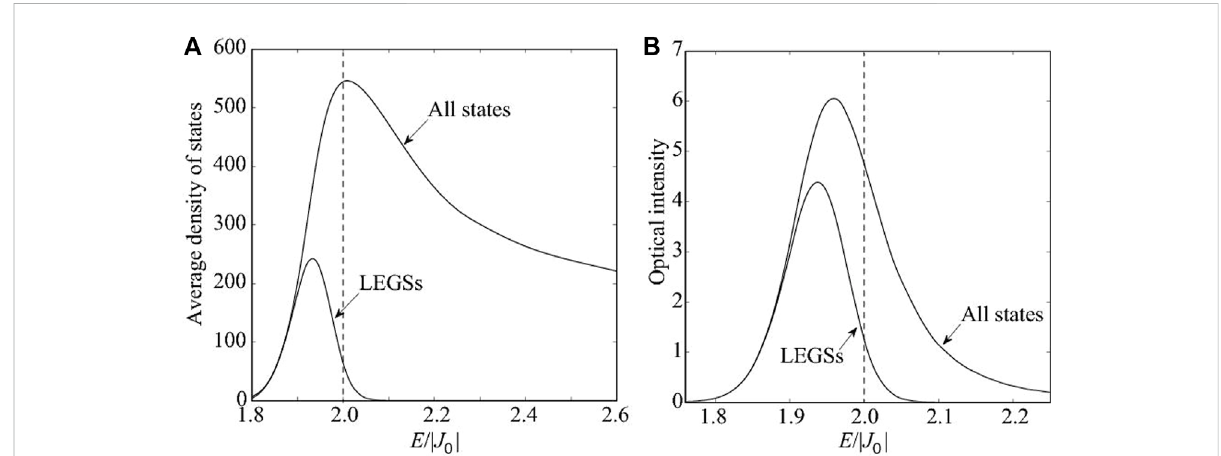
FIGURE 3 (A) The energy density of states and (B) the optical absorption (neglecting the vibronic progression) of the manifold of Frenkel excitons (where | σ J / J 0 | = 0.1). The width of the LEGSs density of states ~| J 0 (cid:4) σ J / J 0 | 4/3 . Similarly, the width of the optical absorption from both the LEGSs and all states ~| J 0 (cid:4) σ J / J 0 | 4/3 . The band edge for an ordered chain is at 2| J 0 | (indicated by the dashed lines), so LEGSs generally lie in the Lifshitz (or Urbach) tail of the density of states, i.e., E < 2| J 0